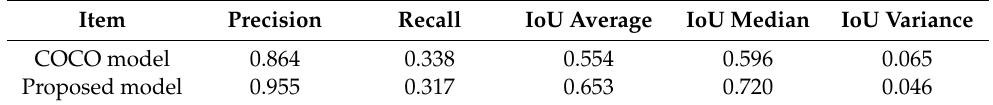
Table 2. The validation results.